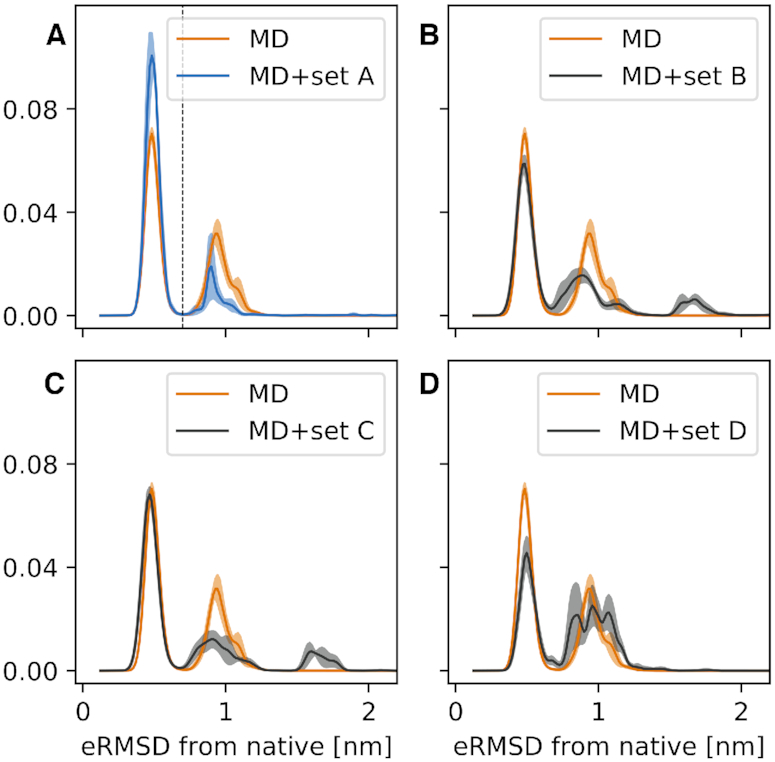
Histograms of the eRMSD from native. The original MD simulation (orange) is compared with the four refined ensembles: MD+set A in panel (A), MD+set B in panel (B), MD+set C in panel (C) and MD+set D in (D). Shades show the standard error estimated using four blocks. The vertical dashed line in panel (A) shows the separation between state A (eRMSD < 0.7) and state B (eRMSD ≥ 0.7).